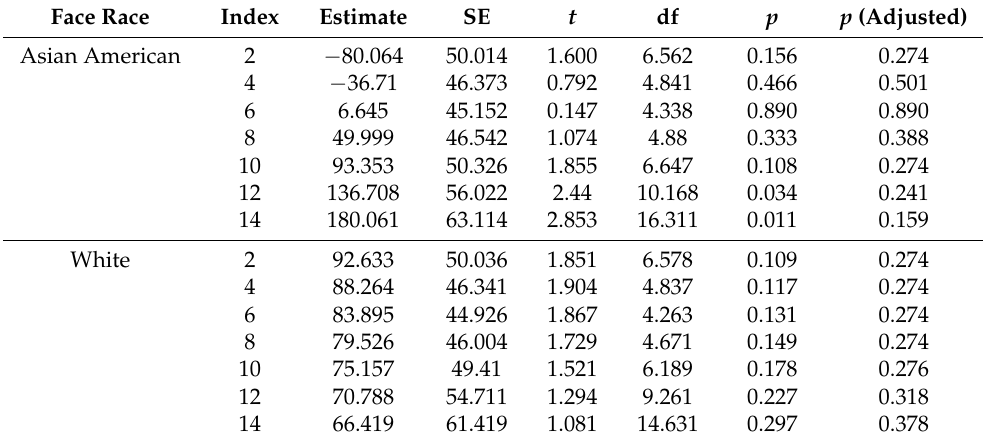
Table 4. The contrasts between fixation duration to the infant-directed and adult-directed stimuli as a function of face race, following up the 3-way interaction of speech type by face race by index from the diversity model. The Estimate is the estimated difference between the means from the model and the SE is the standard error of those estimates. The p -values were adjusted using the False Discovery Rate method.